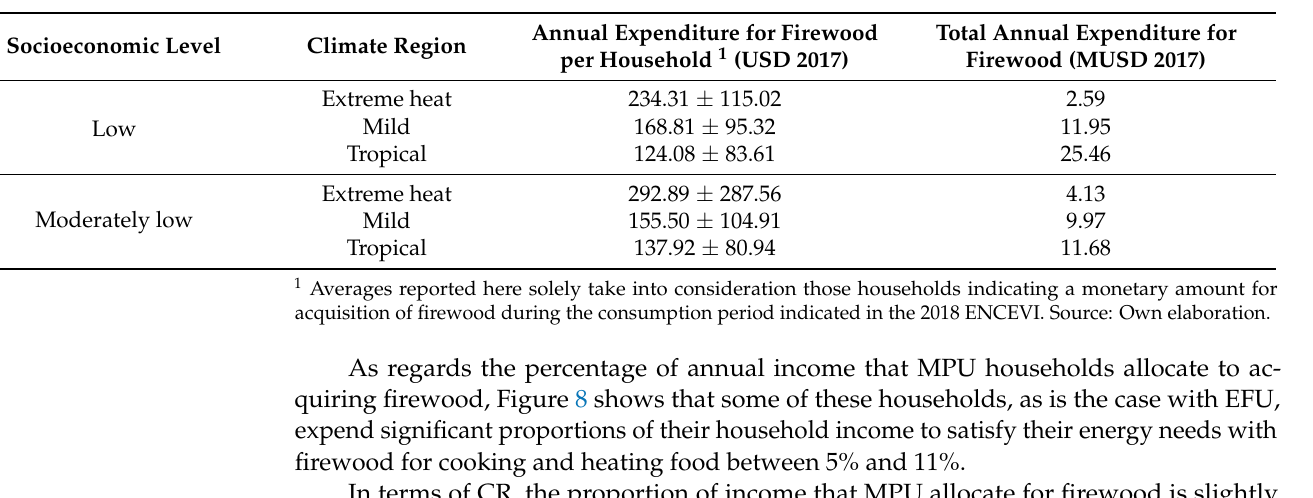
Table 4. Annual expenses per household, and total expenditure for all MPU households, for acquiring the firewood